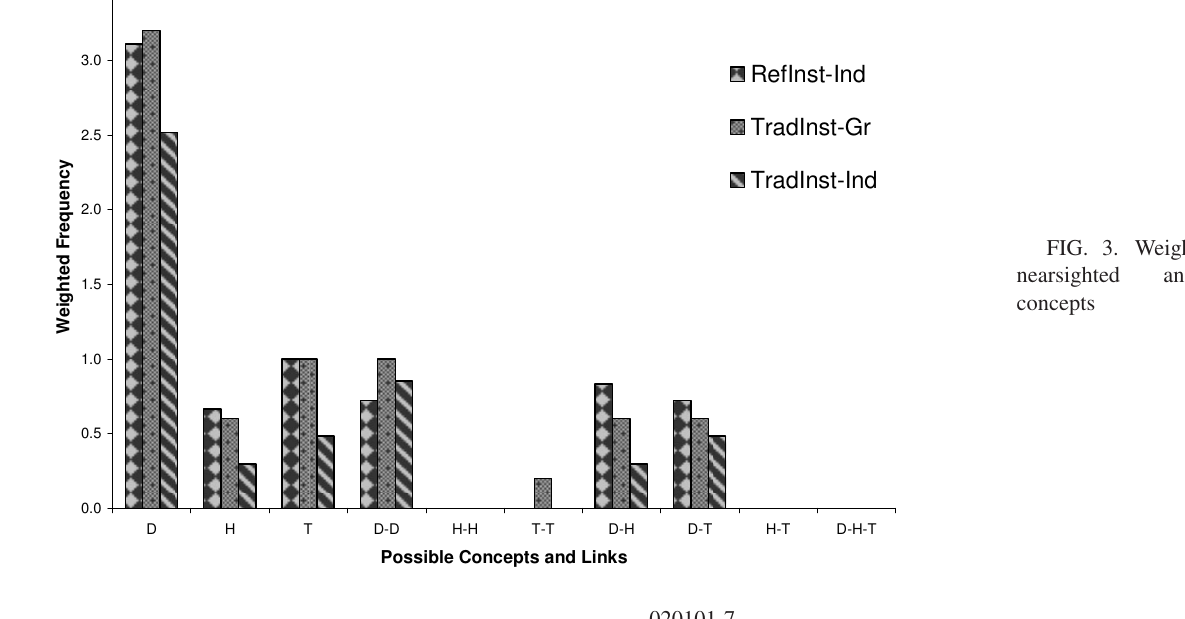
FIG. 3. Weighted data from nearsighted